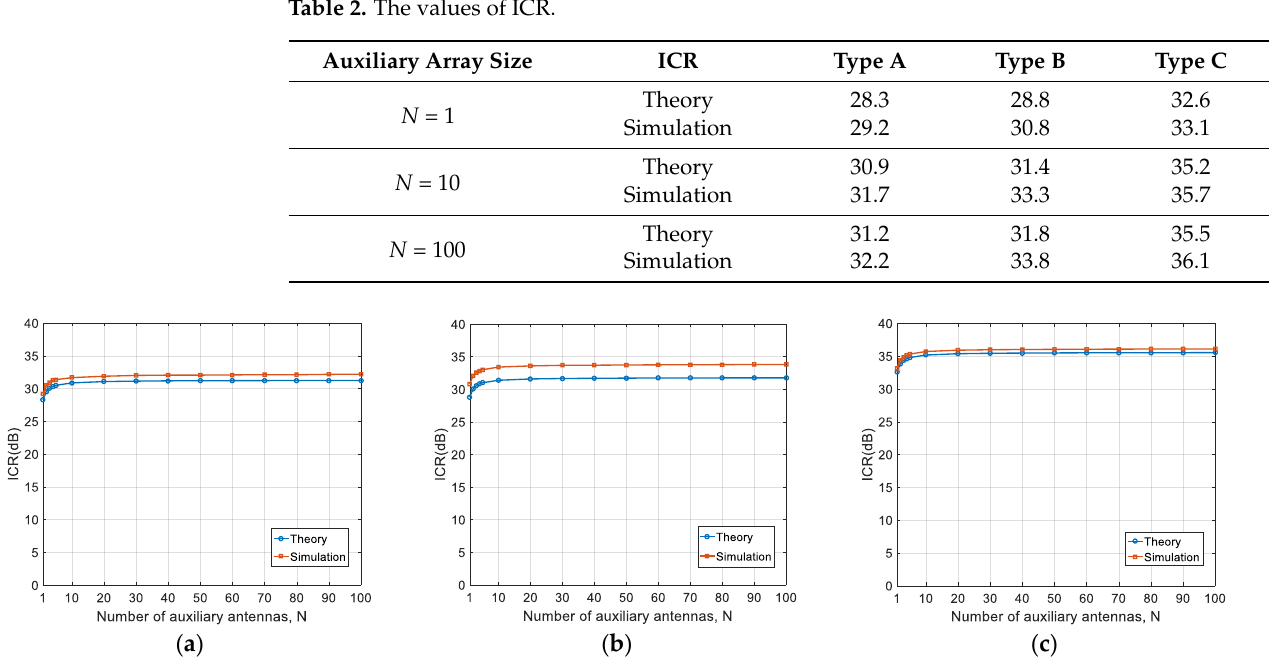
Figure 9. ICR versus the auxiliary array size: ( a ) type A; ( b ) type B; ( c ) type